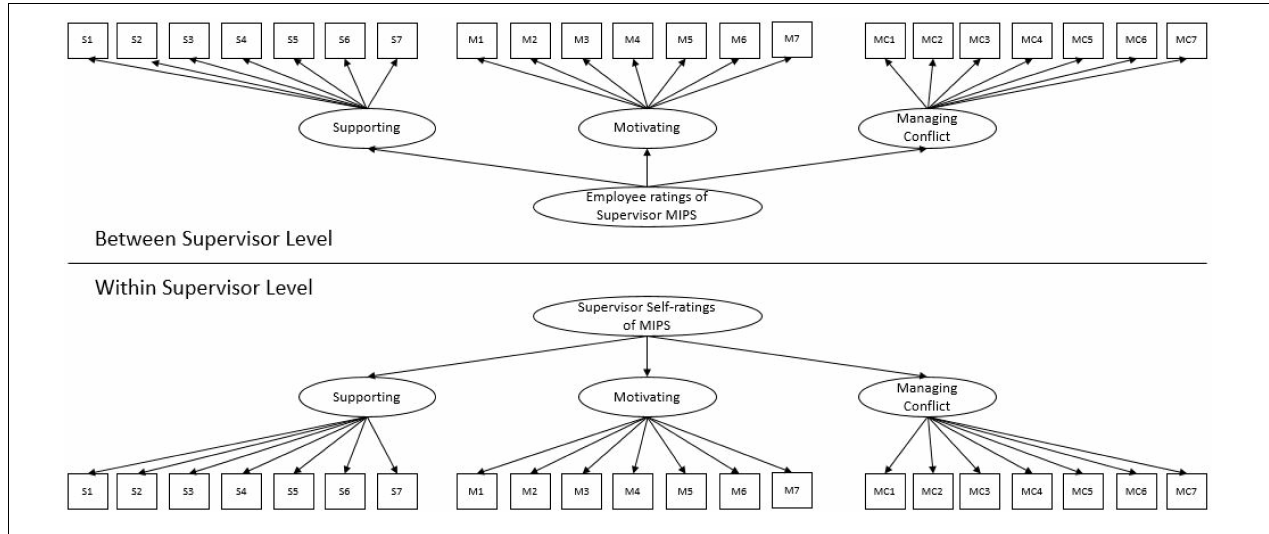
FIGURE 1 | Study 4 multi-level measurement